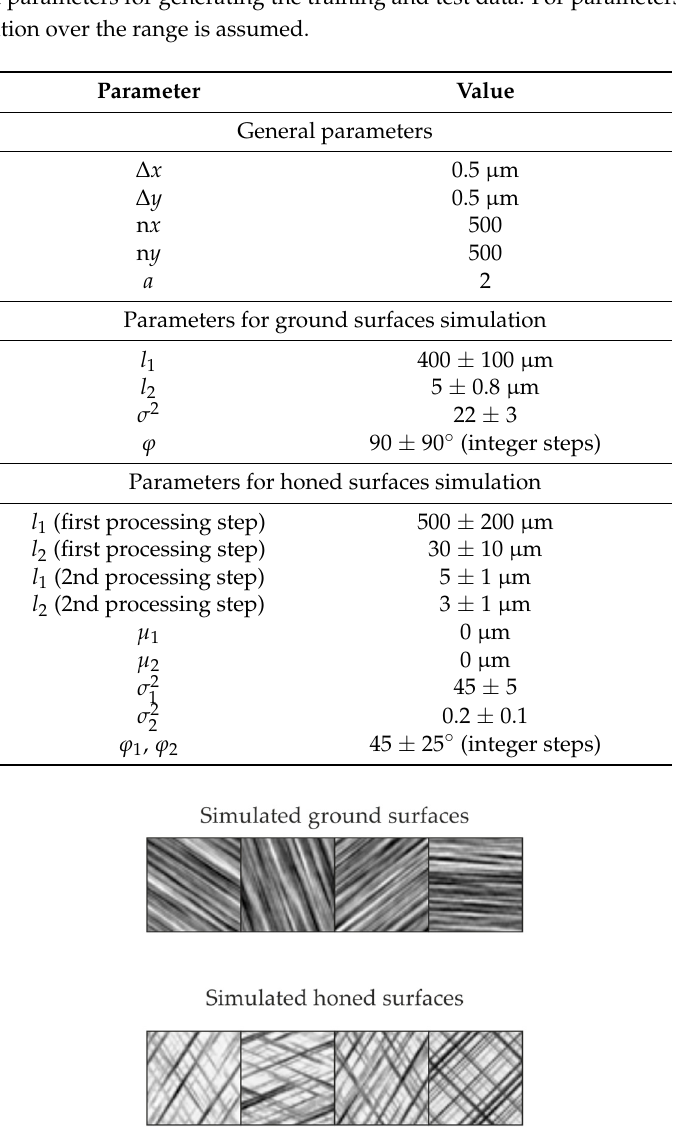
Table 1. Selected parameters for generating the training and test data. For parameters with a range, a uniform distribution over the range is assumed.